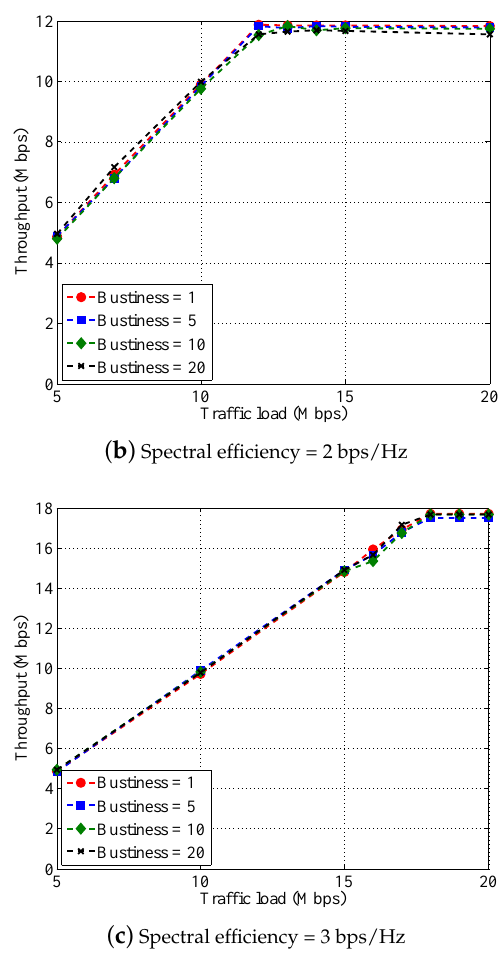
Figure 4. The network throughput at the application layer according to the traffic load (Mbps) when burstiness varies from 1–20 (VBDC).